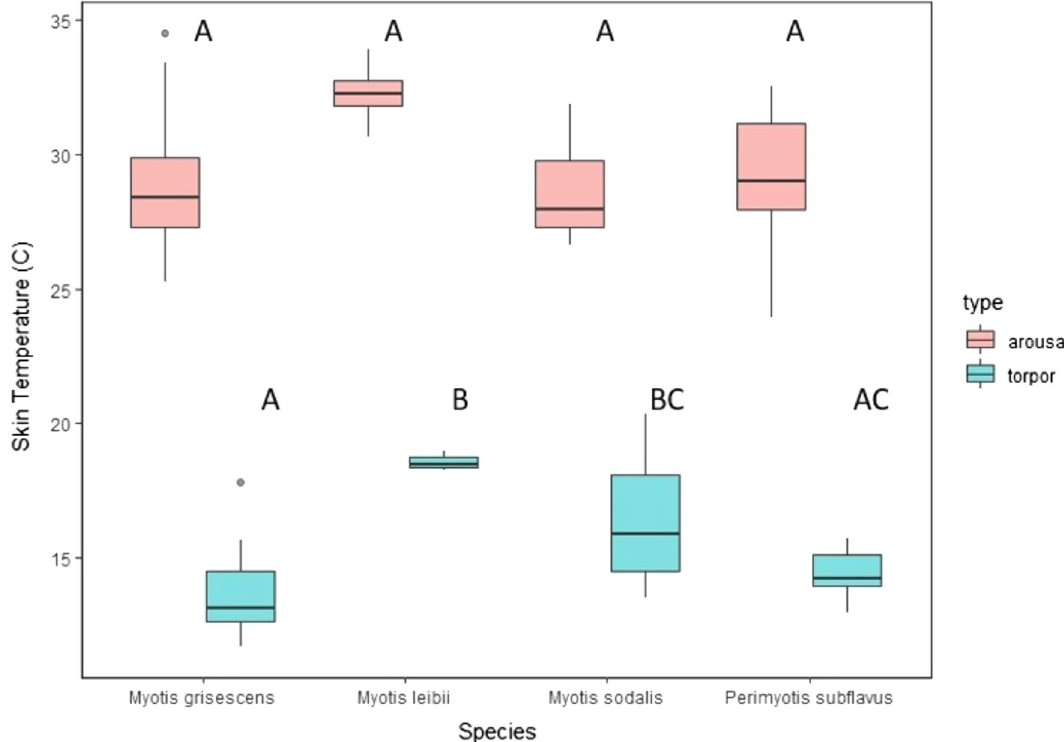
Figure 1. Mean skin temperature ( ℃ ; T sk ) during torpor and arousal of four bat species tracked with temperature-sensitive radio transmitters at four cave hibernacula in Tennessee during hibernation (November 1–March 31) of 2016–2019. Dots above plots represent outlying data. *Boxplot data followed by the same uppercase letter not significantly different ( P >